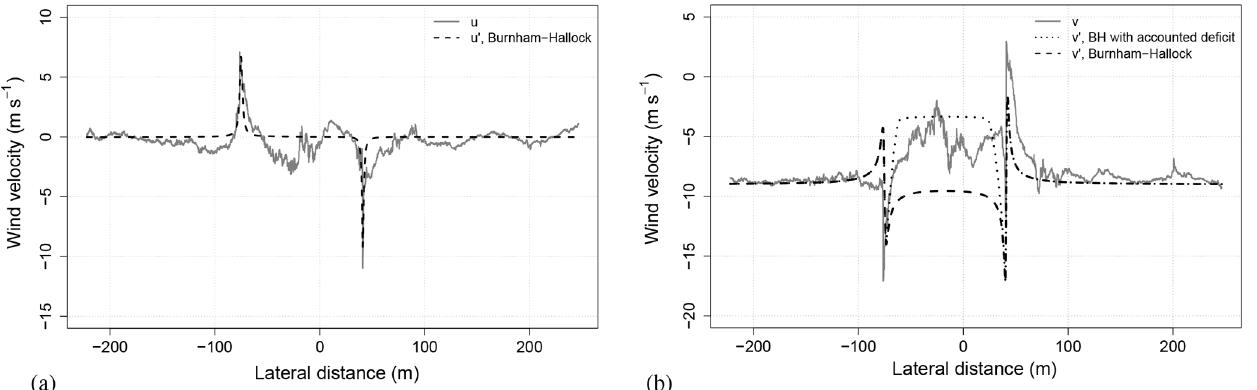
Figure 17. Analytical solution (dashed lines) for u (cid:48) and v (cid:48) of the two vortices from the parameter evaluation. The corresponding wind components ( u and v ) from Fig. 13b from the UAS measurements are in grey. The long dashed solution in panel (b) additionally accounts for the deficit in the